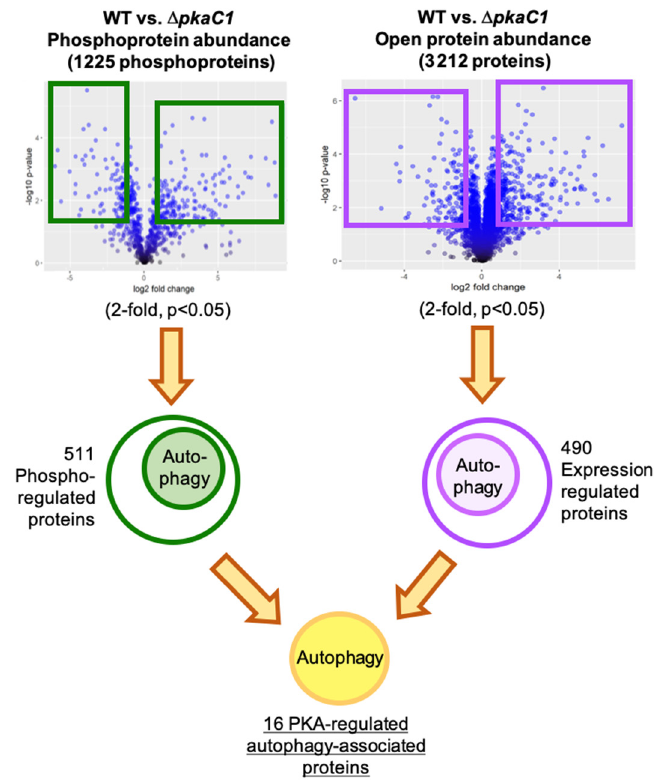
Figure 1. Identification of PKA-regulated autophagy proteins.